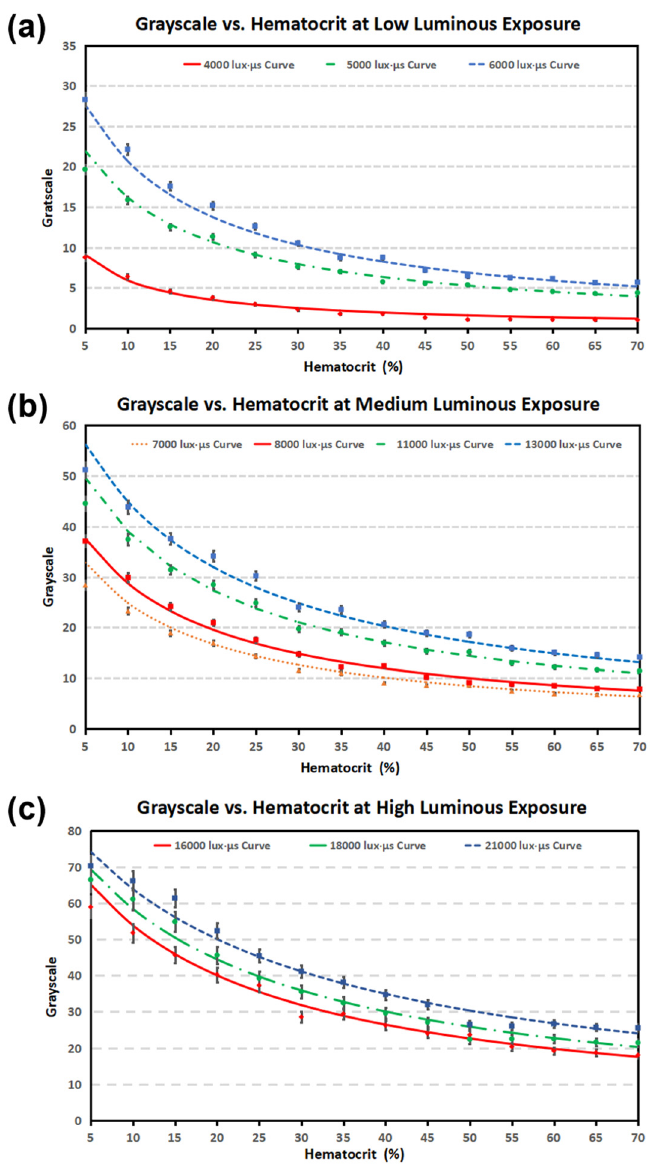
Figure 7. Plots of experimental results of grayscale vs. hematocrit of the blood at different luminous exposures (Hv) within ( a ) the low luminous exposure range (<6000 lux · µ s), with an average R 2 =